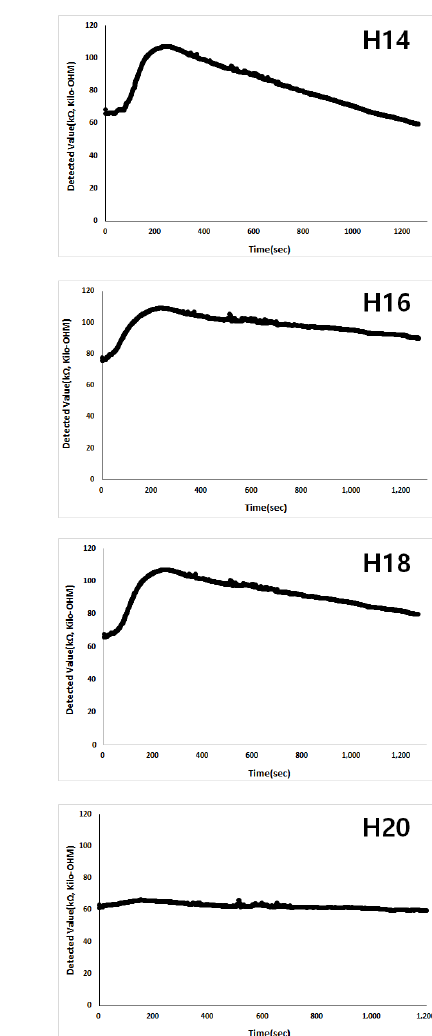
Figure 8. Variation of H9 – H12 CdS photoresistors in sludge sedimentation detecting.